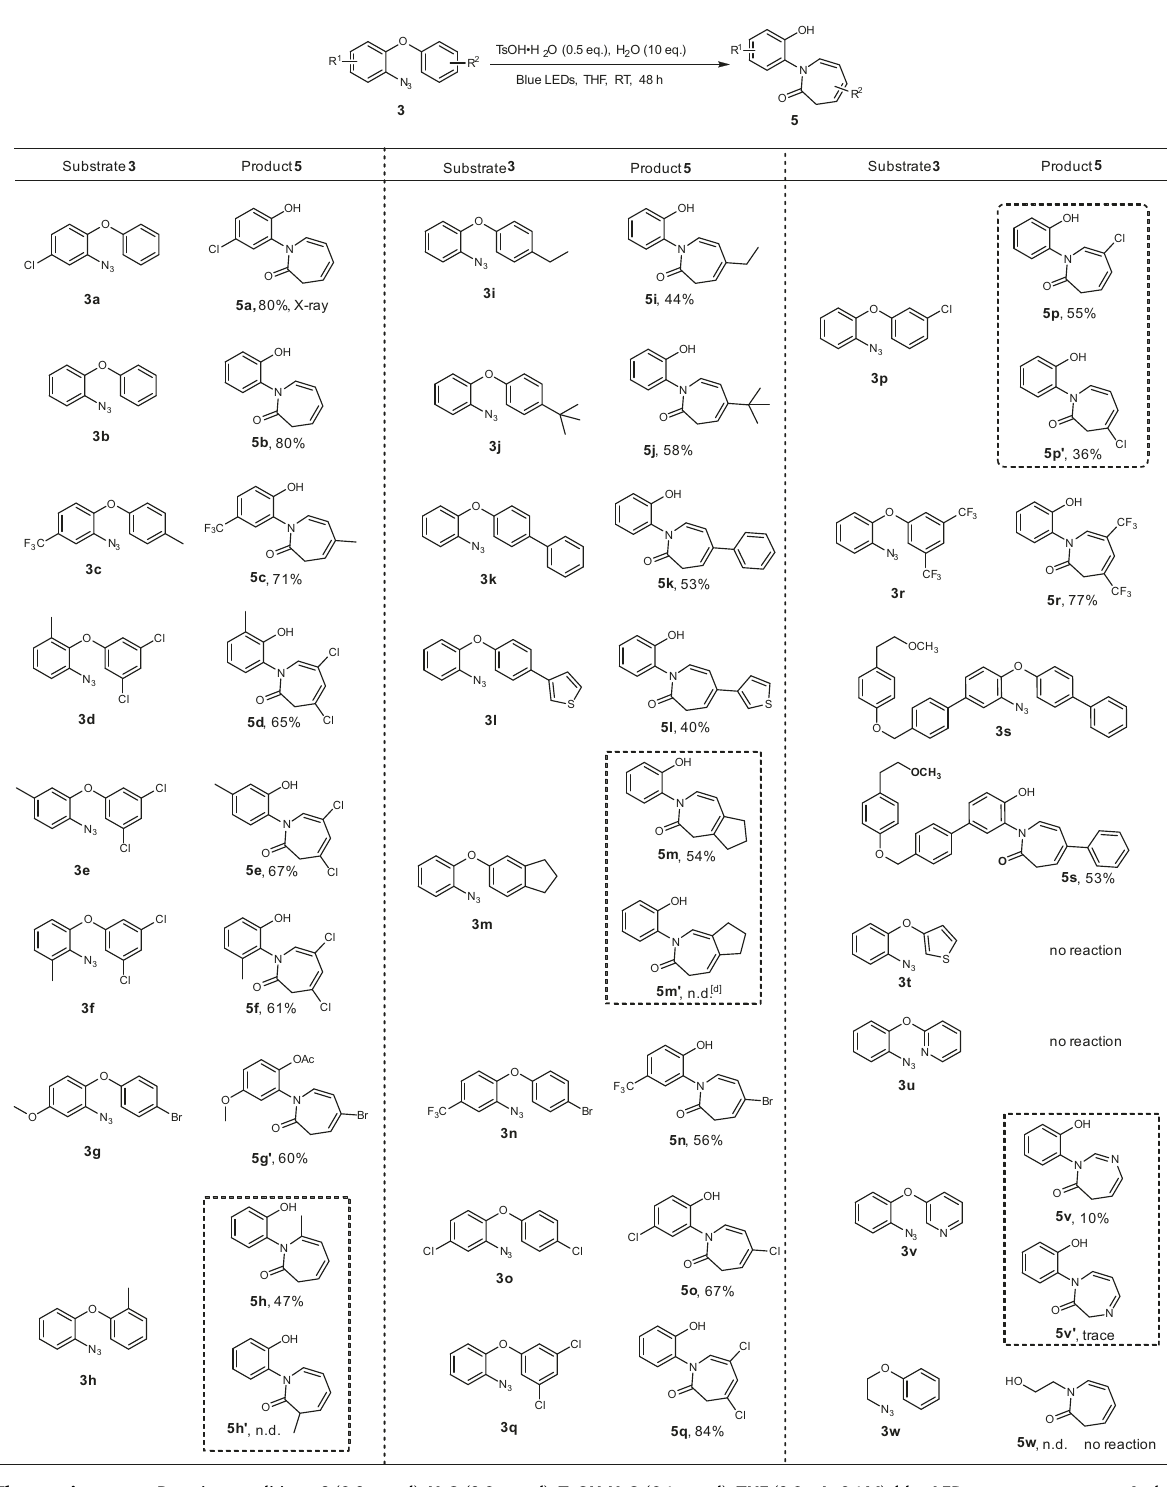
Fig.3|Thereactionscope. Reactionconditions: 3 (0.2mmol),H 2 O(2.0mmol),TsOH • H 2 O(0.1mmol),THF(2.0mL,0.1M),blueLEDs,roomtemperature.Isolatedyields of 5 are given. Compound 5g ’ was obtained by a subsequent transformation: pyridine (1.5 eq.), acetic anhydride (1.2 eq.), CH 2 Cl 2 (1.0mL, 0.1M),